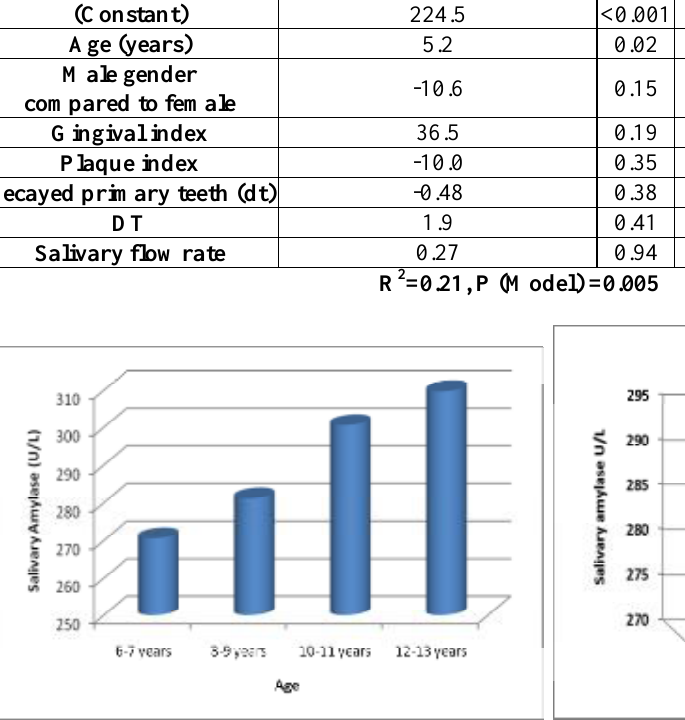
Figure 1: Age group in relation to mean salivary amylase concentration.